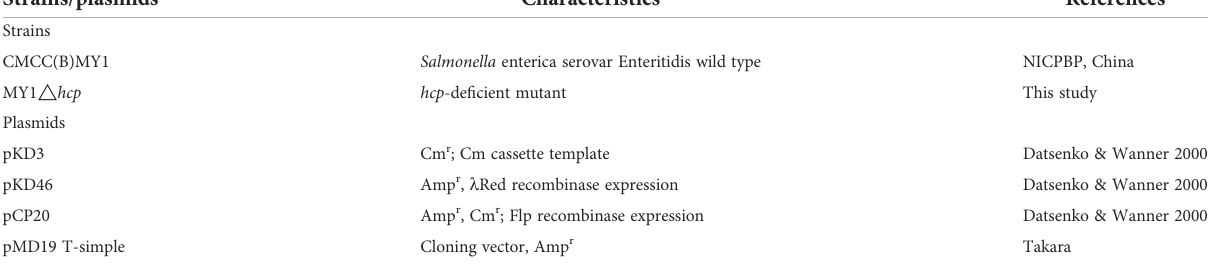
TABLE 1 Bacterial strains and plasmids used in this